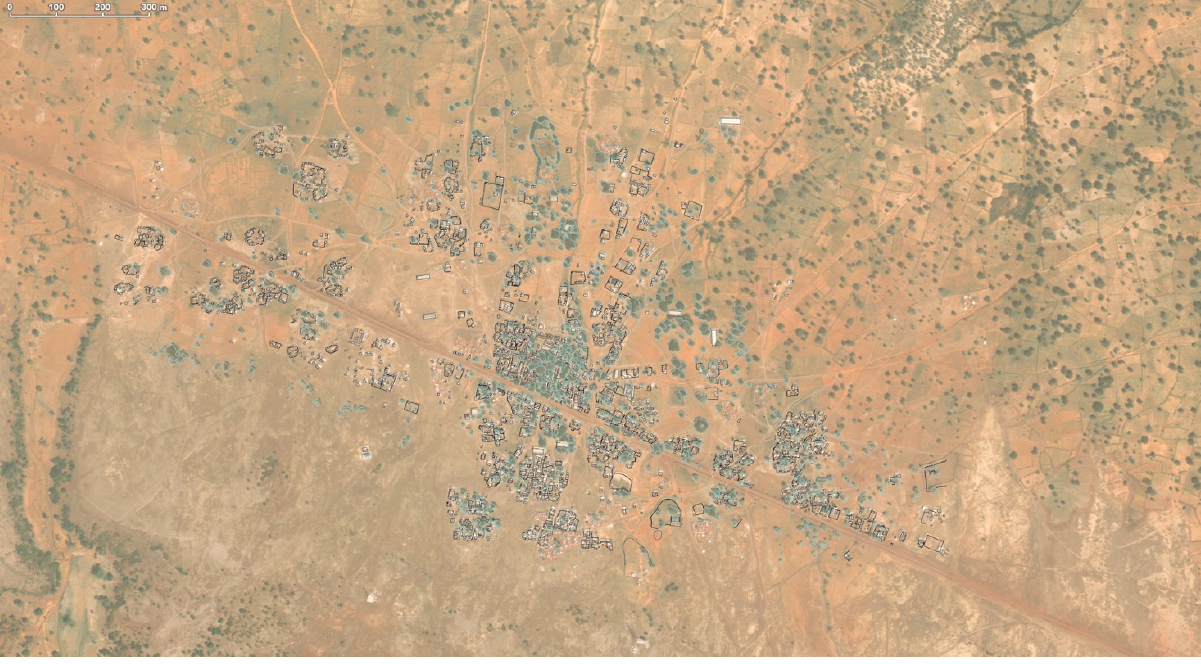
Figure 3. Aerial view and site plan of the village of